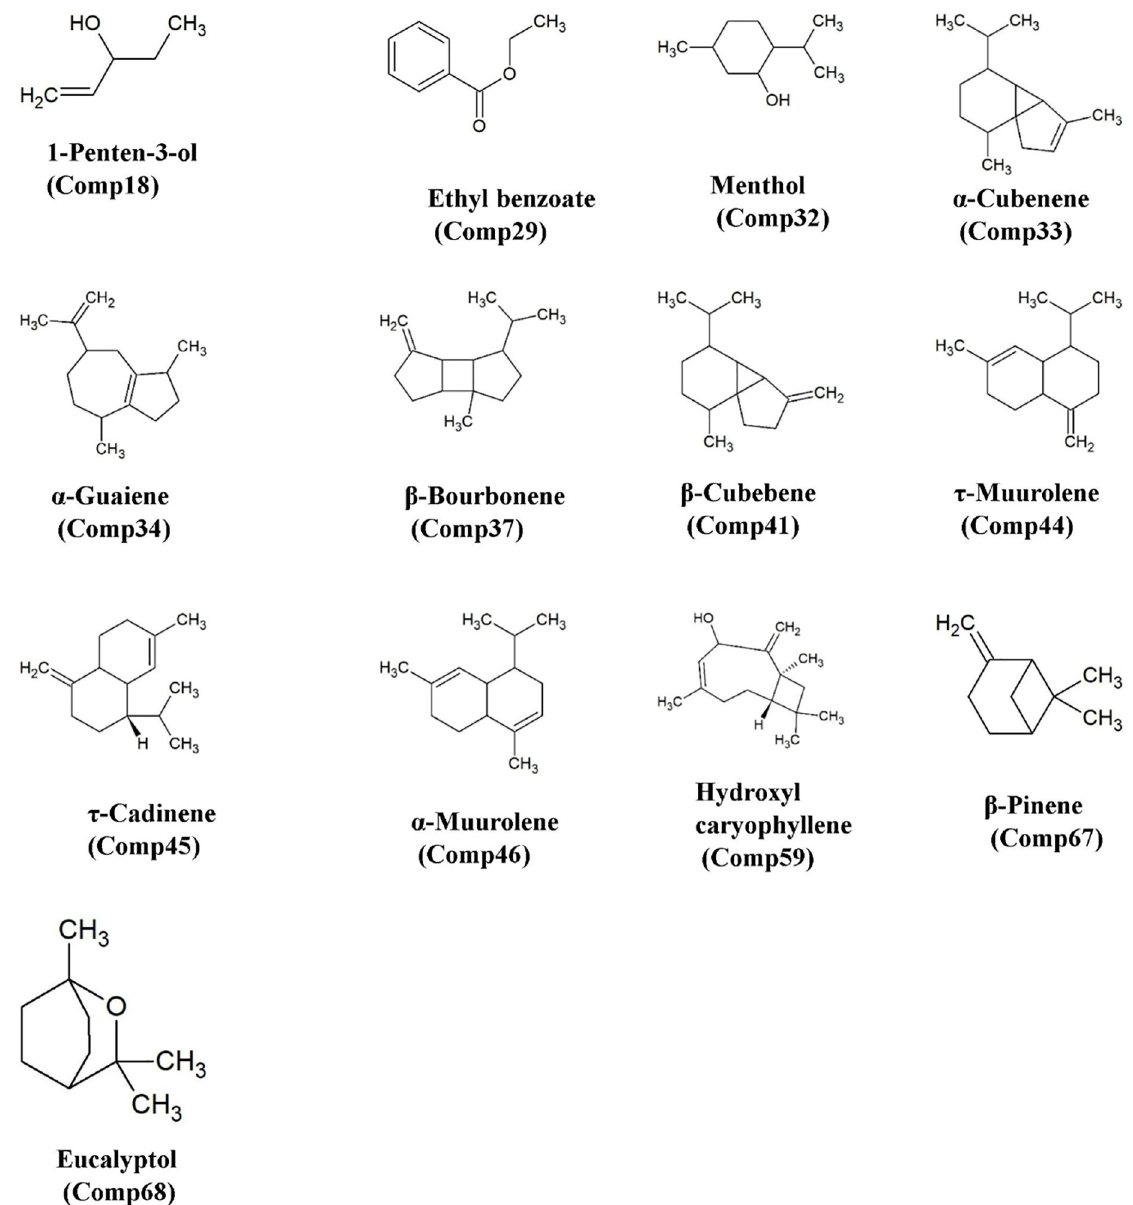
Fig 1. Selected compounds isolated from leaves, fruit, and bark of Ficus carica for molecular